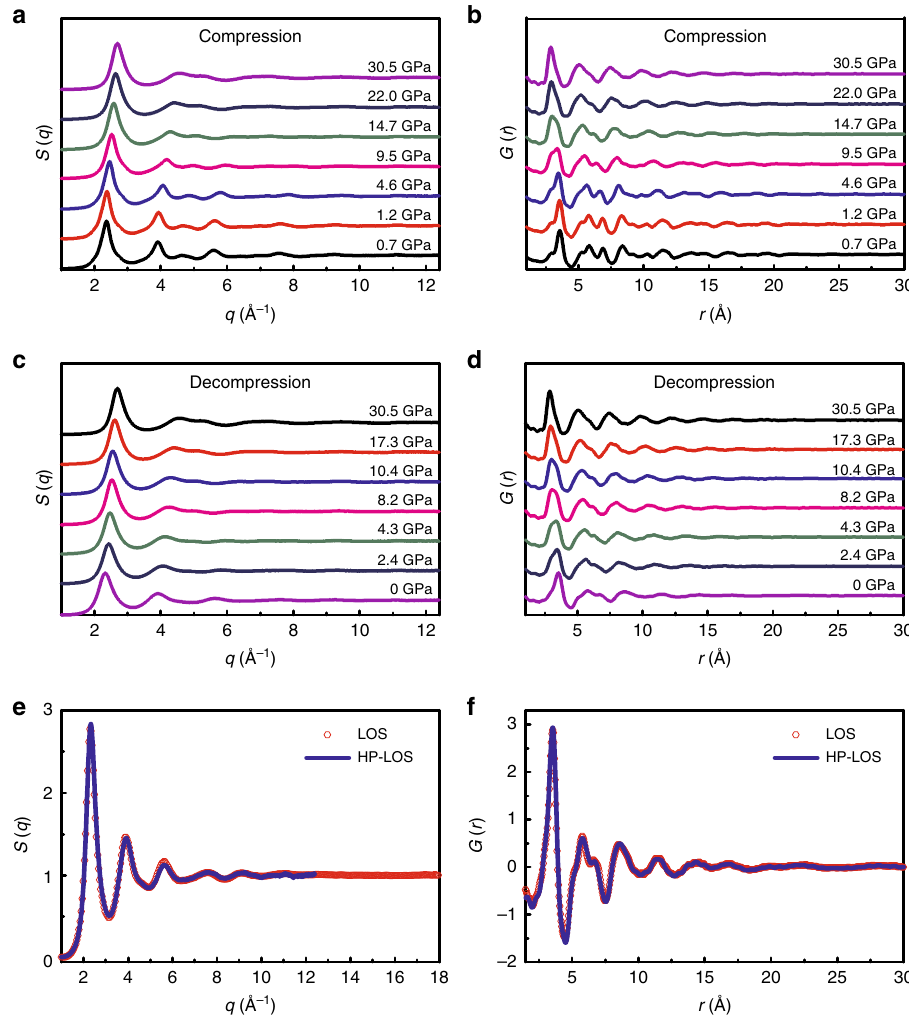
Fig. 3 The structural evolution of the Ce 65 Al 10 Co 25 HOS sample under high-pressure. a S ( q ) and b G ( r ) of the HOS sample during compression, c S ( q ), and d G ( r ) of the HOS sample during decompression. Fewer features in the S ( q ) and G ( r ) after high-pressure treatment indicate that thermal-driven high orderings are gradually erased by pressure. A comparison of the structures of the as-prepared sample (LOS) and the sample recovered from high-pressure experiments (HP-LOS) is shown in e S ( q ) and f G ( r ). The HP-LOS sample (blue line) almost coincides with the as-prepared LOS MG (red circle), suggesting highly similar